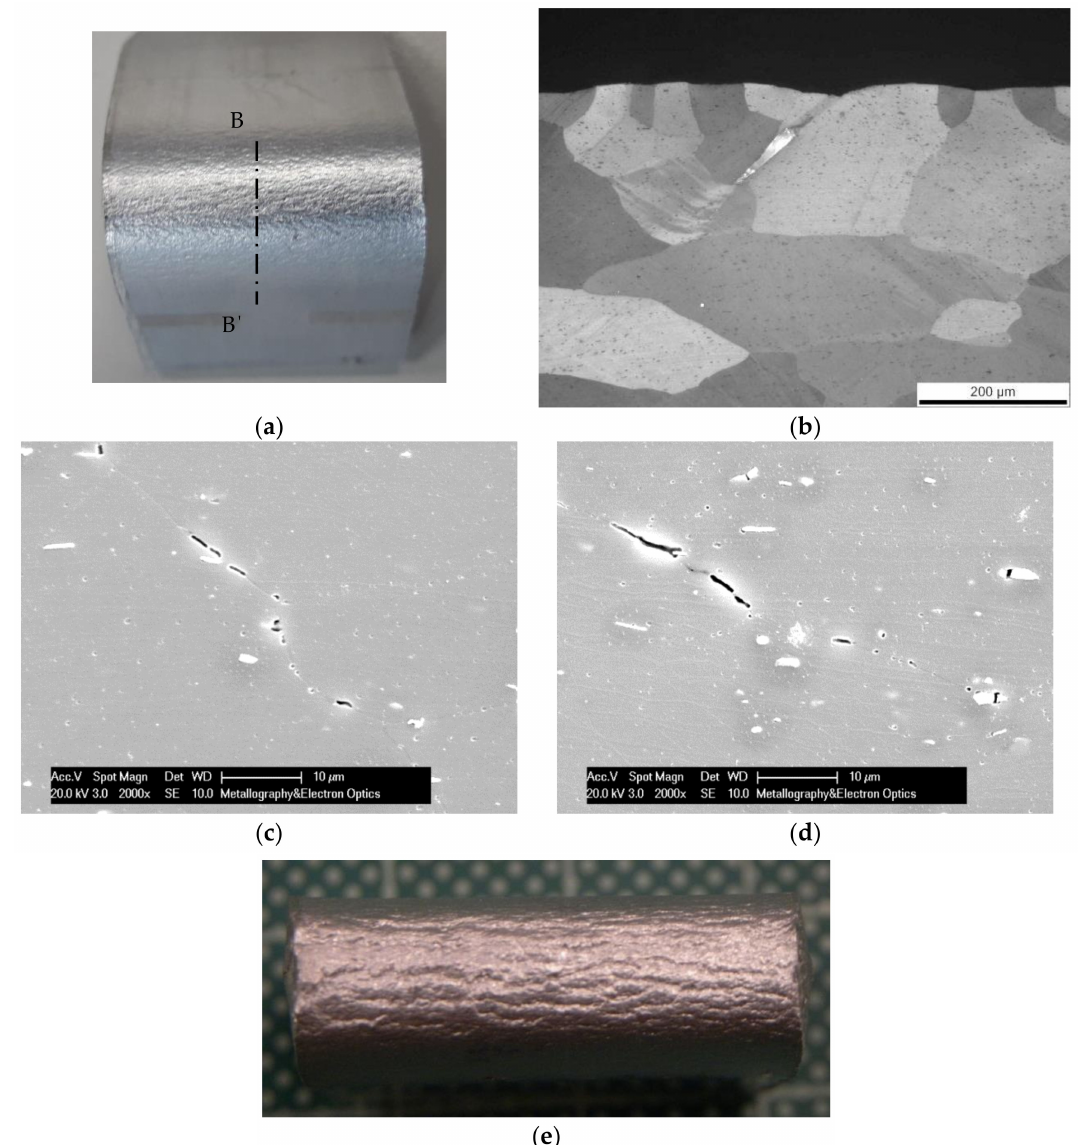
Figure 11. ( a ) Macroscopic image of bent specimen sample with 2.9 mm thickness (end of bending test at 10% load drop, longitudinal bend test with bend line transverse to extrusion direction). ( b ) Optical micrograph, cross-section B-B’ showing mainly intergranular cracking on the surface. ( c , d ) SEM micrographs, grain boundary debonding and rupture. ( e ) Macrograph, end of bending test at 180